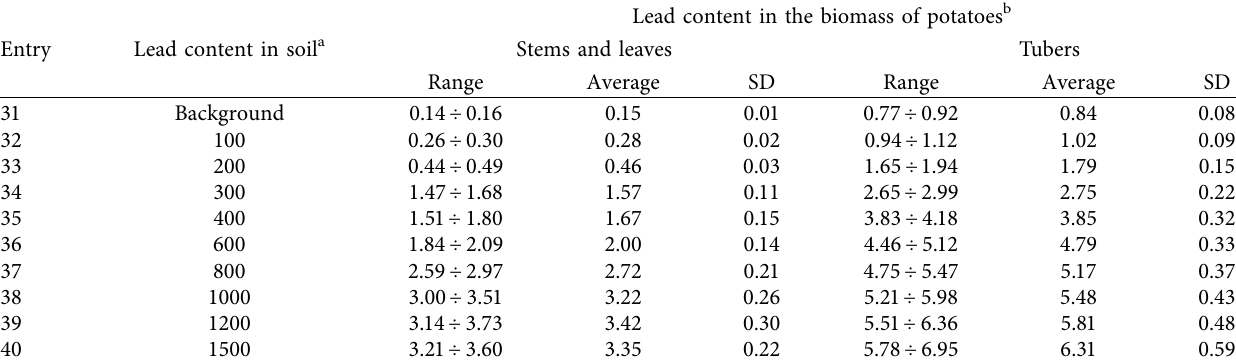
a, mg/kg of dried soil; b, mg/kg of fresh vegetable.